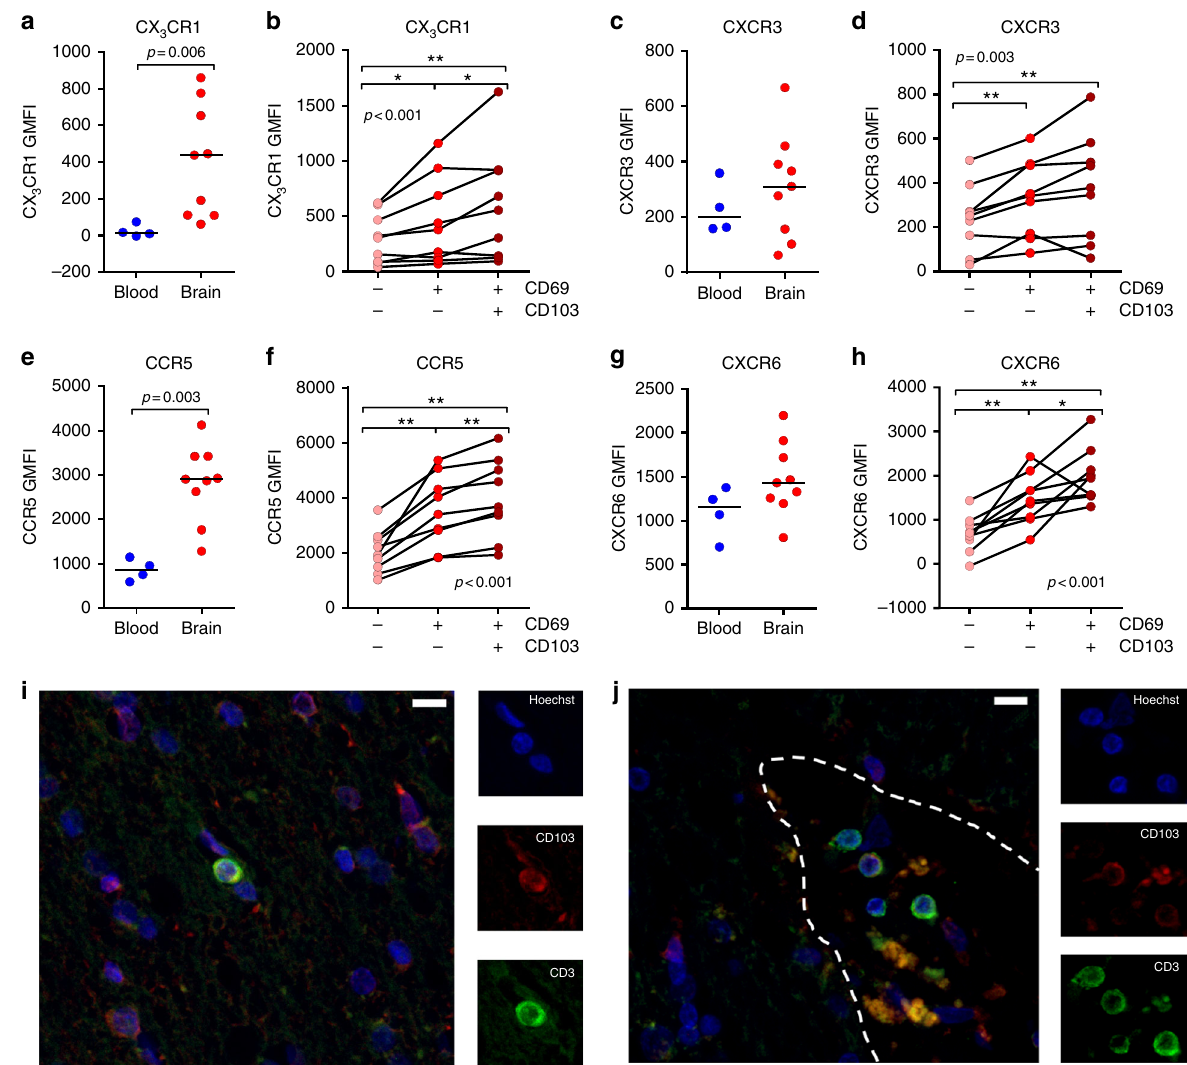
Fig. 4 Human brain CD69 + CD103 + CD8 + T cells are enriched for tissue-homing chemokine receptors. a – h Quanti fi cation of CD8 + T-cell expression levels of CX 3 CR1, CXCR3, CCR5, and CXCR6 (GMFI, geometric mean fl uorescence intensity). Bars show median values. p -values show Mann – Whitney U test for unpaired data ( a , c , e , g ) and Friedman test for paired data with Wilcoxon signed ranks as post hoc test ( b , d , f , h ) (* p < 0.05, ** p < 0.01); no brackets indicate no signi fi cant difference. i , j Immuno fl uorescent staining for CD3 and CD103 of paraf fi n tissue shows a parenchymal ( i ) and perivascular ( j ) localization of CD3 (green) and CD103 (red) immunoreactive cells. Borders of the perivascular space were designated based on histological hallmarks (i.e., lymphocytes in close relationship with the extraluminal side of a blood vessel) and are marked with a dotted white line (scale bar = 10 µ